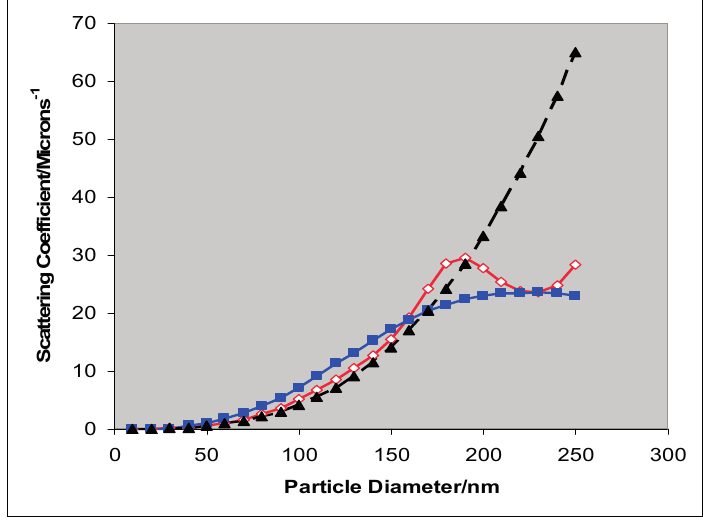
Figure 1. Rayleigh ( ▲ , dashed line) and Mie scattering ( ◊ and ■ , full lines) of 555 nm radiation by isolated rutile spheres as a function of particle diameter. The curves plotted through ▲ and ◊ , points assume that all particles are of identical. The curve plotted through the ■ points assumes a log-normal distribution of particle size.